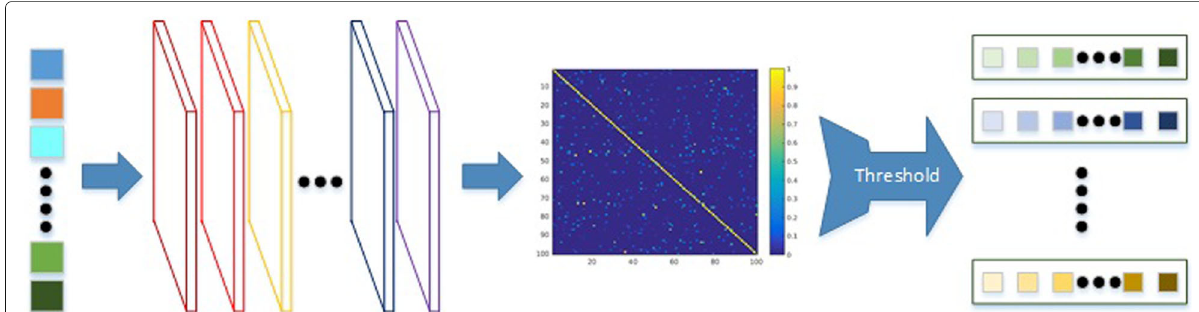
Fig. 3 The flow chart of obtaining the coarse categories. Firstly, Trunk-NET generates the probability of every training image. Secondly, Eq. 1 generates similarity map with the probability of every training image. Thirdly, according to the similarity map, Algorithm 1 engenders coarse categories with threshold